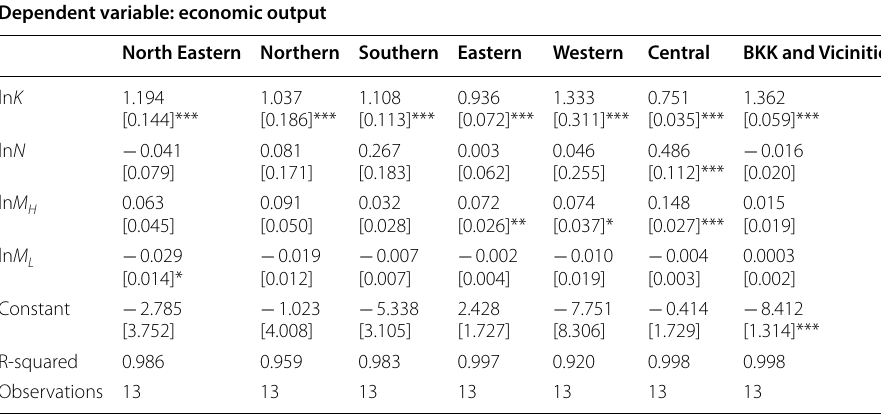
Standard errors are in parentheses *, **, *** indicate significant at 10%, 5%, and 1% level of significance, respectively